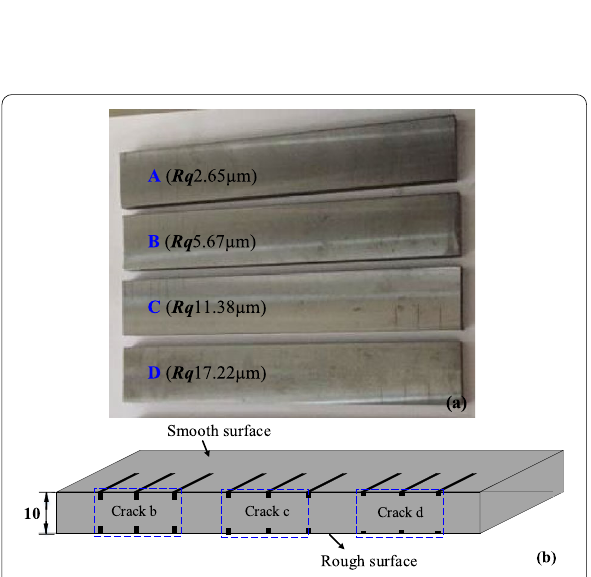
Figure 10 a Samples with different surface roughness, b Micro-crack distribution on rough surface and reference surface